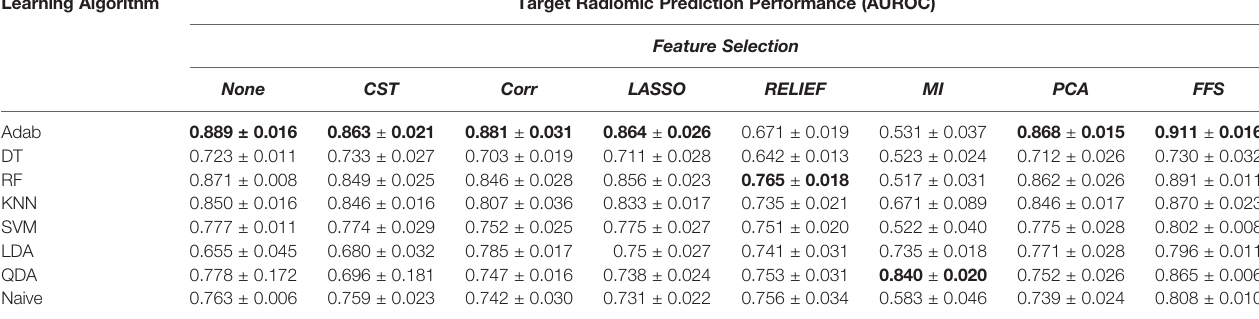
For each feature selection algorithm, the highest value is marked in